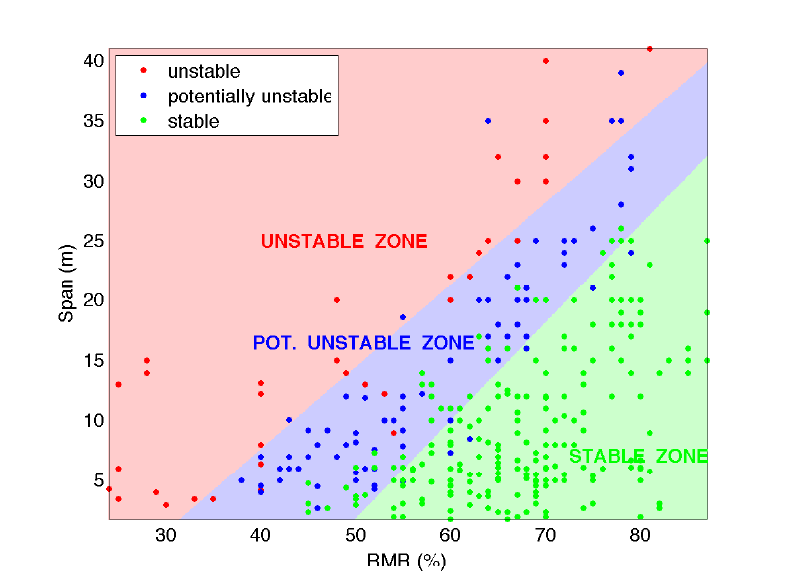
Figure 3. Critical span graph: SVM classification into three groups with the linear